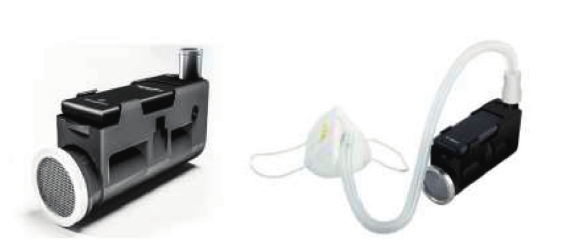
Figure 9: Produced UV-C air sterilization device.